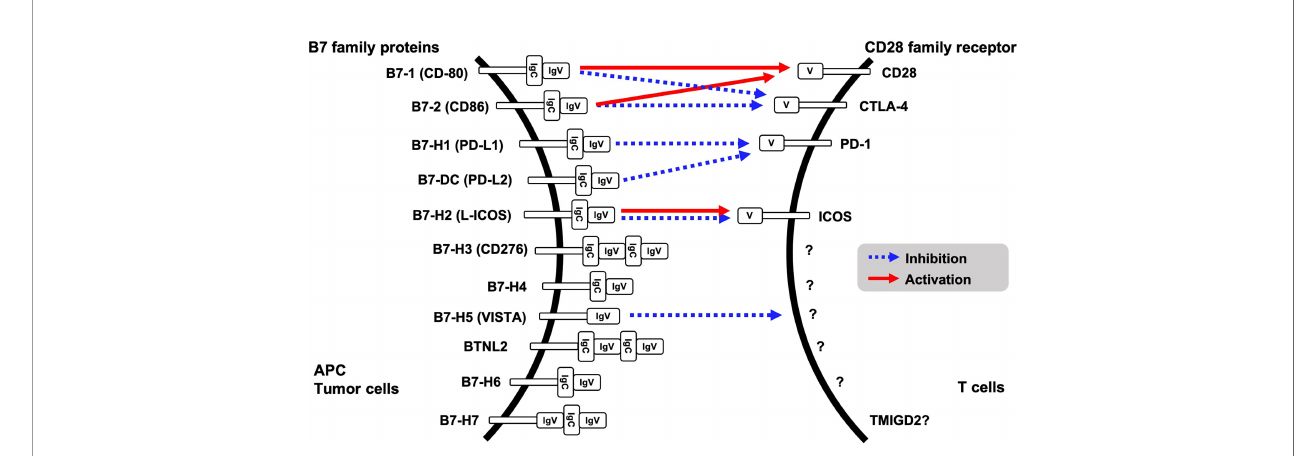
FIGURE 1 | B7 family proteins and its